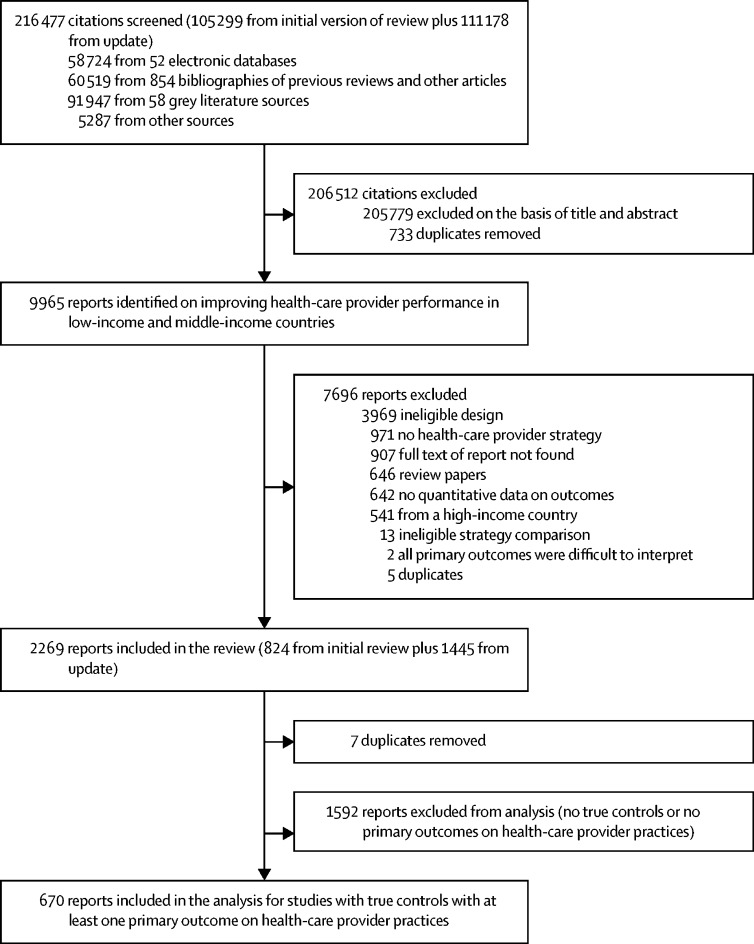
Study selection